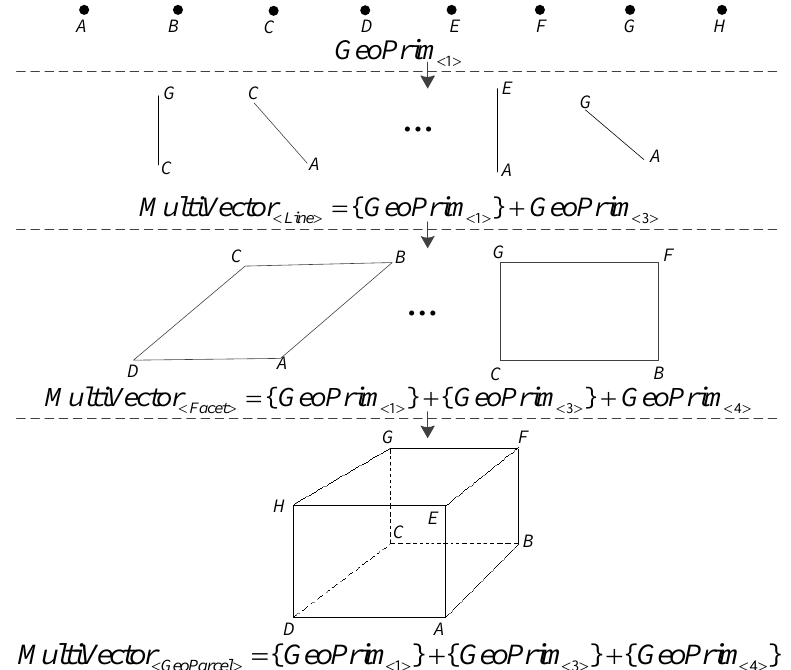
Figure 6. Process of integrating the representation of the geometry and topology of a 3D cadastral spatial unit in CGA.